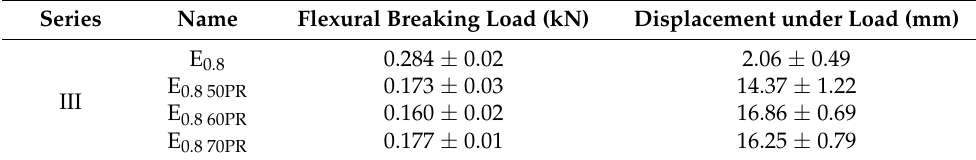
Table 3. Flexural breaking load of boards and displacement under load (UNE-EN 520).